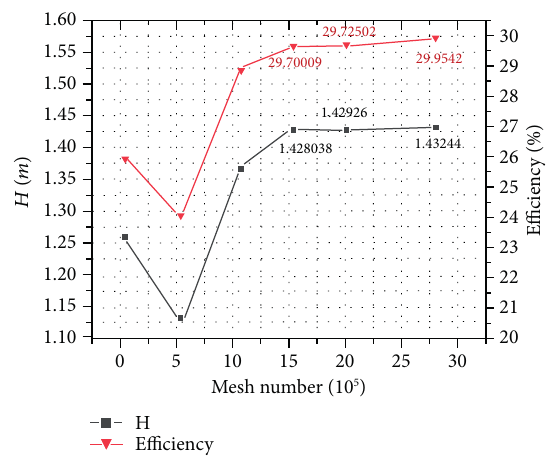
Figure 4: Mesh independency test.